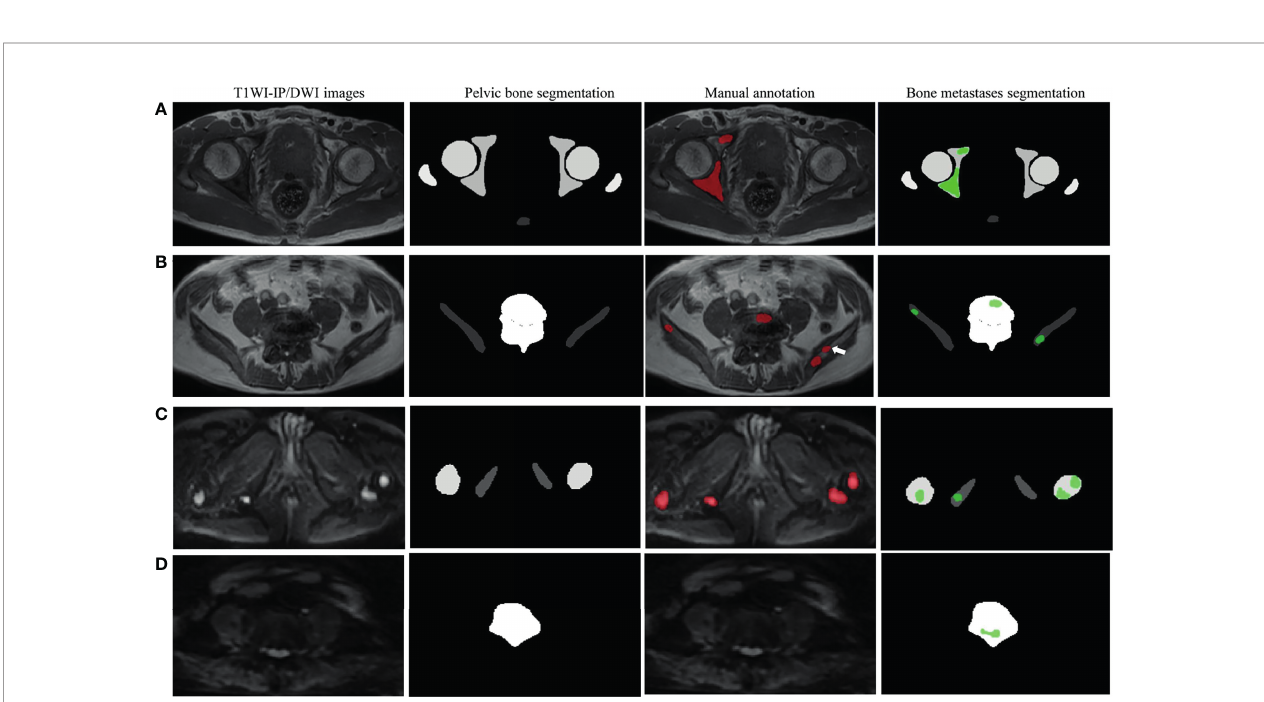
FIGURE 5 | Examples of pelvic bony structure and bone metastases segmentations. (A) Two metastases of acetabulum annotated by radiologists were corrected segmented by the model on T1WI-IP images (true positive). (B) Four of fi ve metastases annotated by the radiologists were corrected segmented by model on T1WI- IP images; one metastasis on the right ilium was missed (the white arrow pointed, false negative). (C) All the four metastases of femoral head and ischium annotated by radiologists were correctly segmented by the model on DWI images (true positive). (D) One metastasis of lumbar vertebra was segmented by the model by error, which was not annotated by the radiologists (false positive). T1WI-IP, T1W images obtained using the Dixon technique with in-phase.